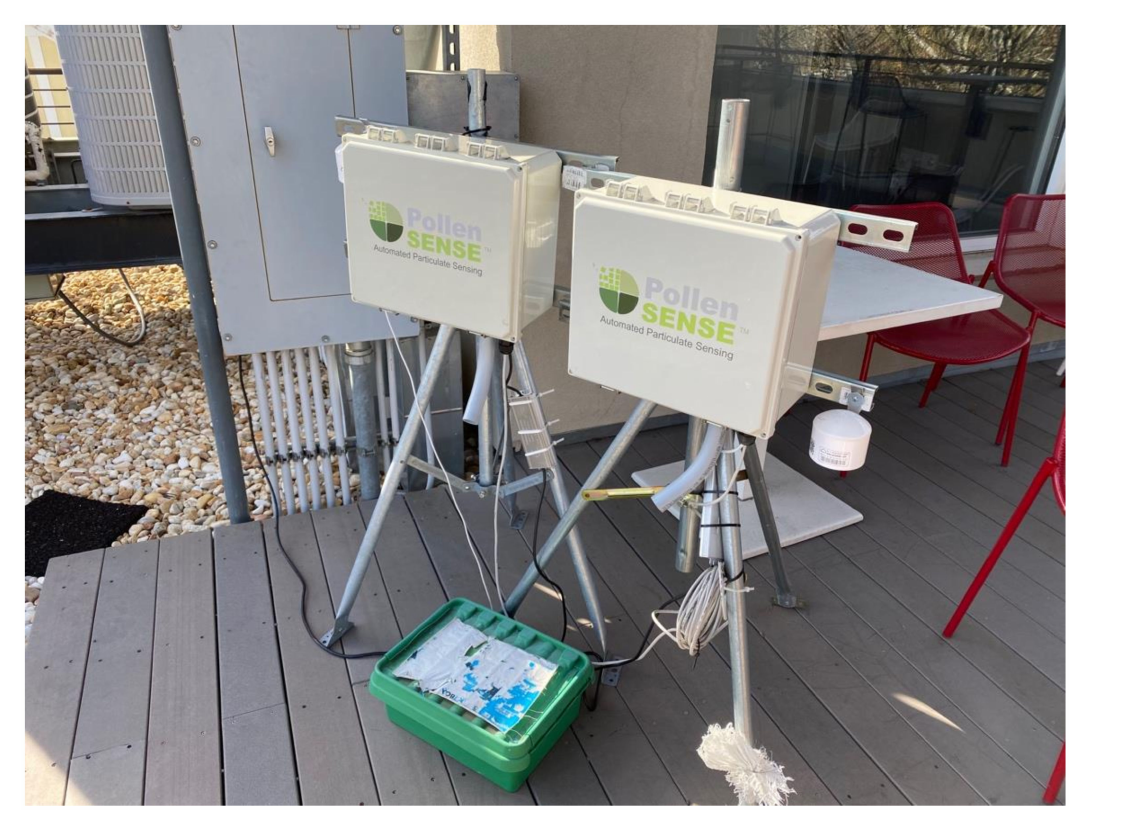
Figure A1. Colocation of two APS-300 sensors at the Southface Site for the internal consistency